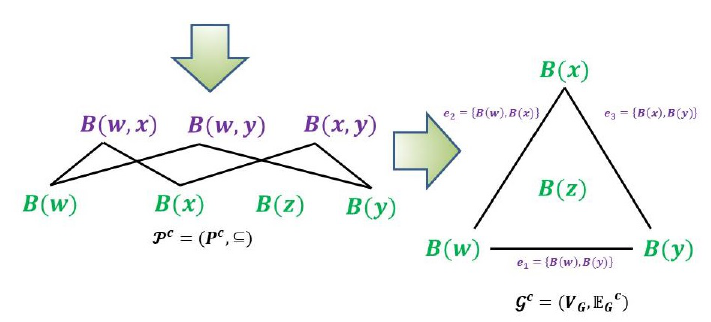
Figure 7 — A Graph G and Its Associated Graph Lattice Ω( G )